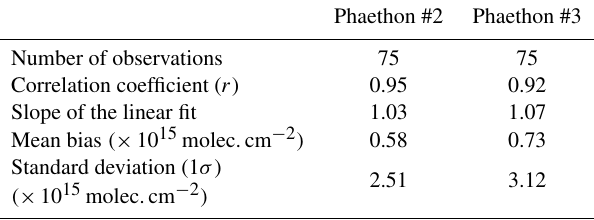
Table 2. Tropospheric NO 2 statistics from the comparison of Phaethon #2 and #3 systems to Phaethon #1 during the period 11– 19 October 2014. The hourly averaged vertical columns at both 15 and 30 ◦ elevation viewing angles are compared.